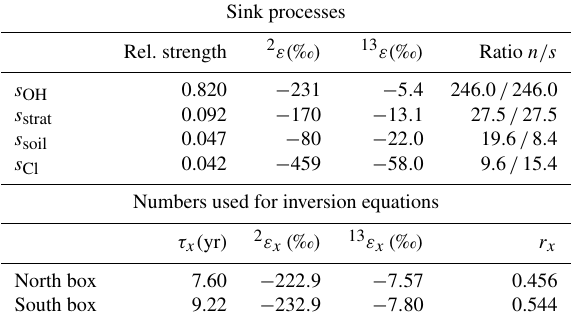
Table 5. Values used in our box model inversion. Relative strengths, isotopic fractionations ( 2 ε and 13 ε) (Cantrell et al., 1990; Tyler et al., 1994; Brenninkmeijer et al., 1995; Irion et al., 1996; Gierczak et al.,1997; Quay et al., 1999; Feilberg et al., 2005), the north–south ratio of the individual sink processes (ratio n/s ), and the parameters for each hemisphere used in our CH 4 box model